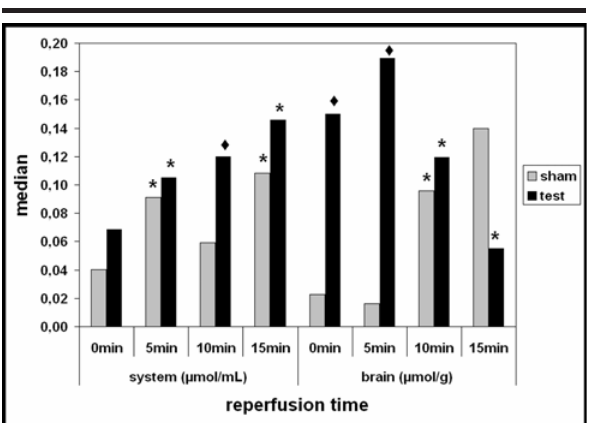
FIGURE 3 - Systemic and brain ketone bodies (ACT+BHB) concentrations in sham and test groups at different times of reperfusion. [ ♦ ] p<0.05 compared with respective sham group; [ * ] p<0.05 compared with similar previous group (Mann-Whitney U